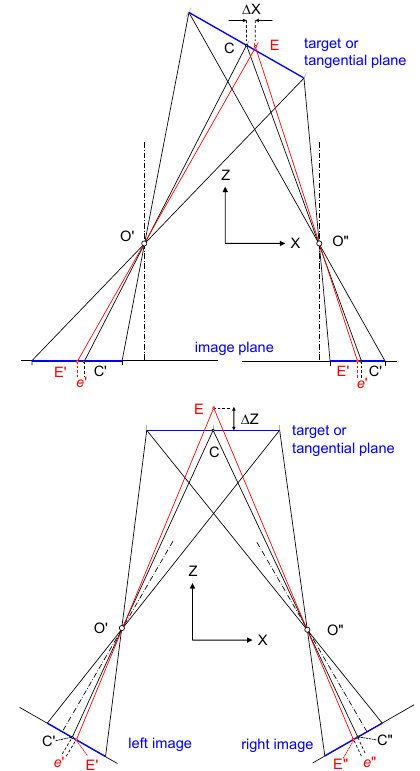
Figure 12: 3D point errors caused by eccentricity in projection for parallel images (top) and convergent images (bottom) As a representative configuration, a stereo camera with two industrial video cameras as specified in the previous section is investigated. Using a stereo base of b =300mm two variants are simulated: a) a normal case configuration with parallel optical axes and b) a convergent configuration with j =±10°.